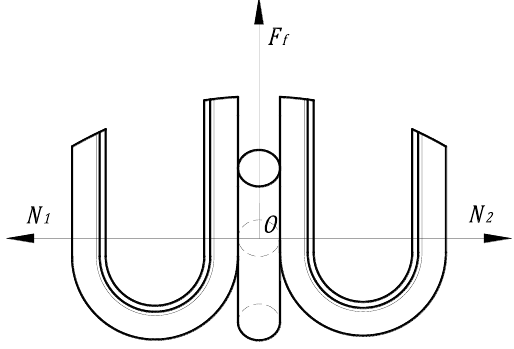
Figure 9. Schematic of the cross-sectional forces of rape shoot